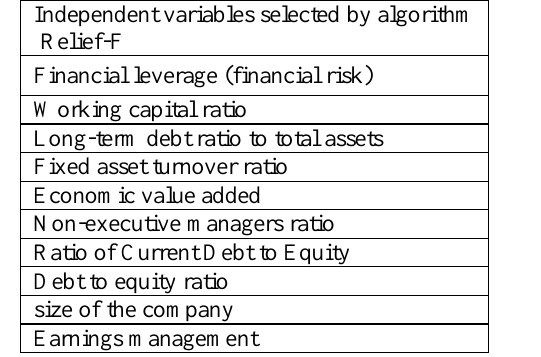
Table 4: Selected independent variables along with weight (significance) to predict